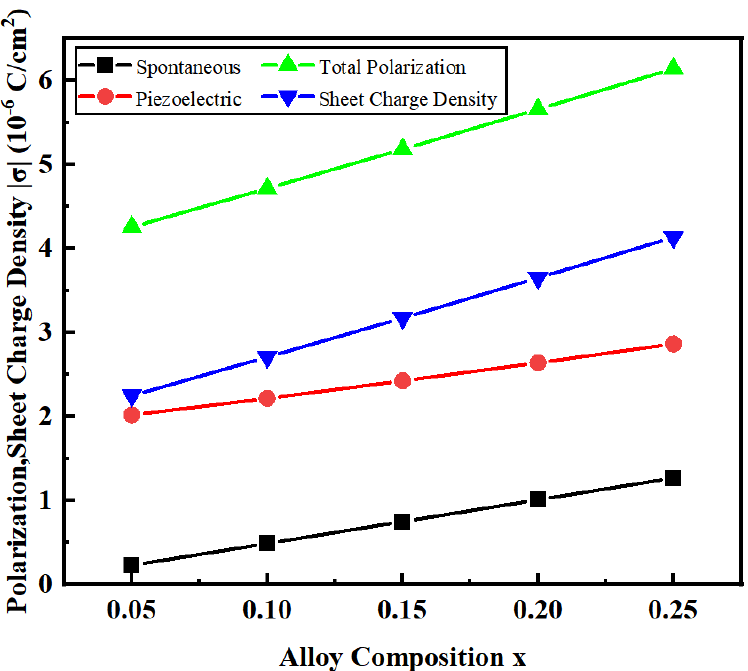
Figure 3. When d AlGaN = 20 nm, d In0.1Ga0.9N = 5 nm, and r = 0.5, the AlGaN barrier layer is fully strained. The spontaneous, piezoelectric, total polarization of AlGaN and sheet charge density at the AlGaN/InGaN interface of an AlGaN/InGaN/GaN heterostructure at different Al content.